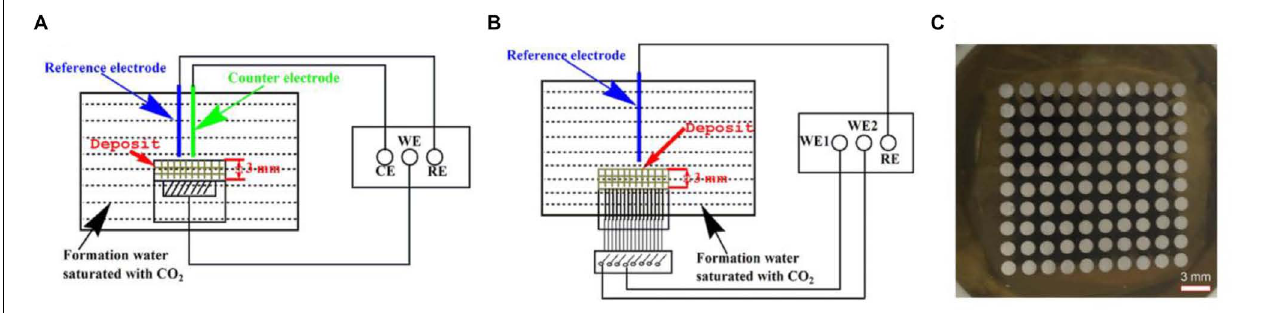
FIGURE 1 | Schematic diagrams of the setup for electrochemical measurements (OCP, EIS, and potentiodynamic polarization curves) (A) , the setup for potential and galvanic current measurements (B) using a WBE (C) .